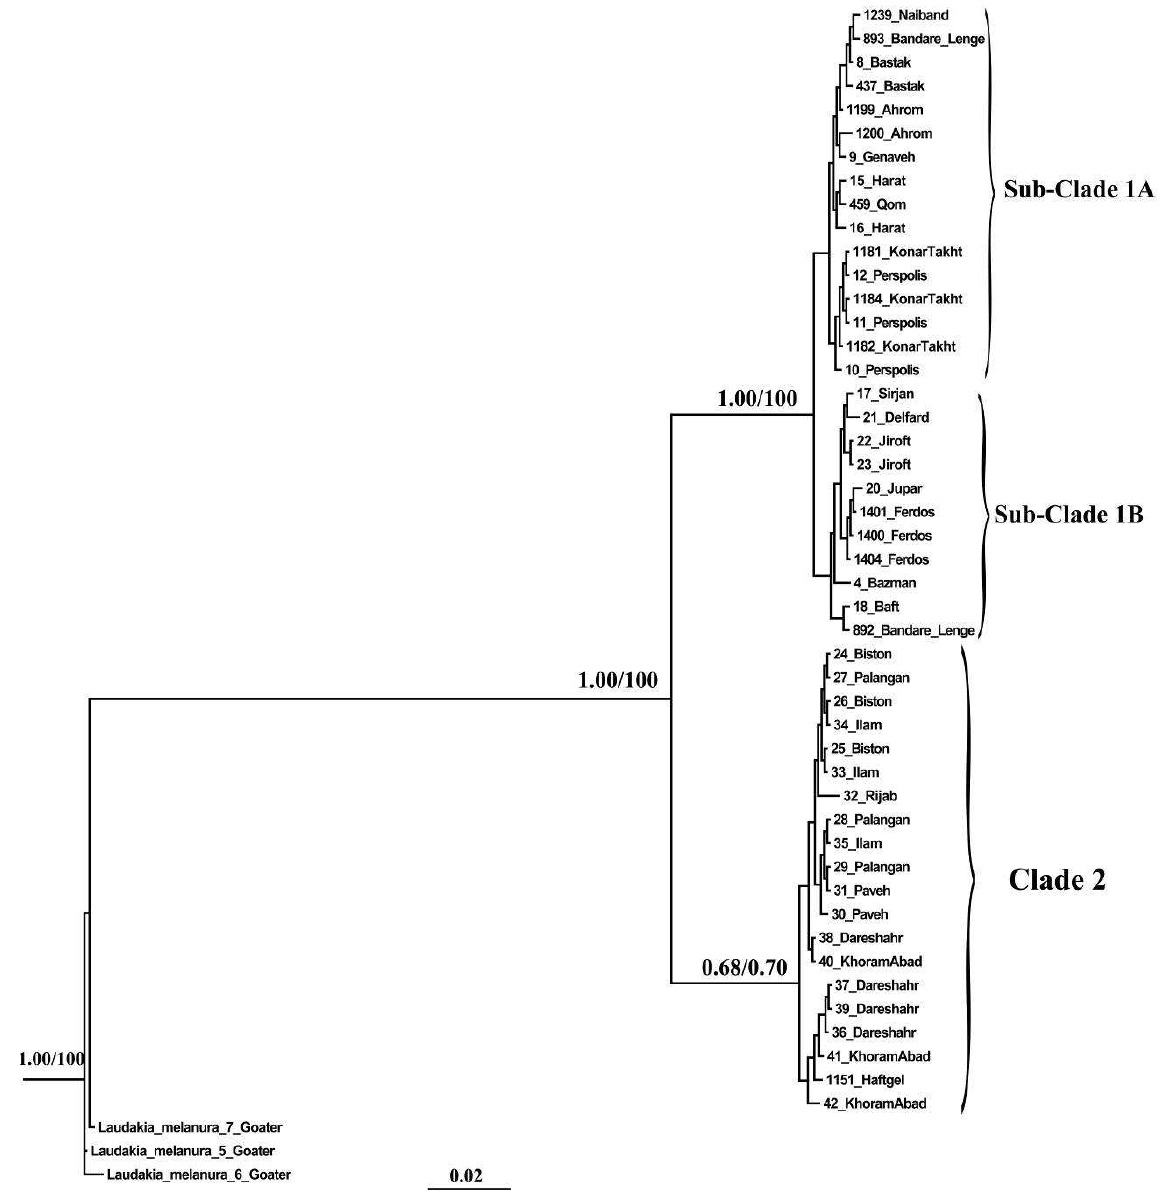
F IGURE 2. Phylogenetic relationships between different populations of Luadakia nupta (Bayesian inference) based on the 859 bp of ND4 (tRNAsHis+Ser+Leu). L. melanura was designated as out- group taxon. Numbers next to the nodes indicate clade credibility (Posterior probability) followed by bootstrap values obtained under ML Tree with 1000